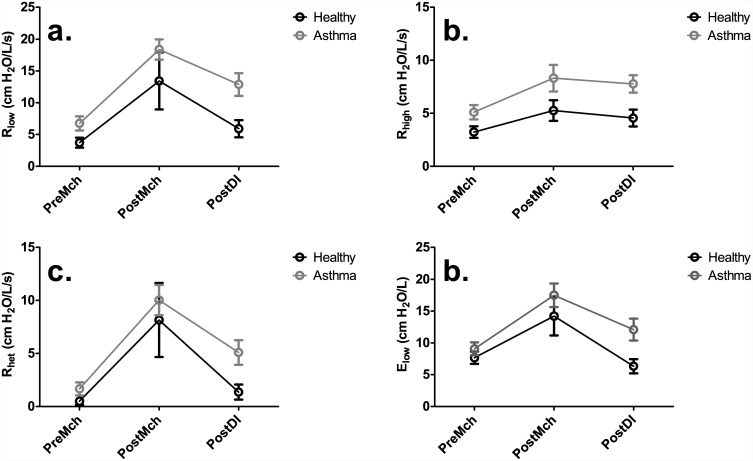
Dynamic lung mechanics measurements for PreMch, PostMch, and PostDI conditions, for Rlow (a.), Rhigh (b.), Rhet (c.), and Elow (d.) with corresponding standard errors.Again, across all three conditions, the mean values of all four indices of dynamic lung mechanics, Rlow, Rhigh, Rhet, and Elow for the asthmatic subjects were consistently higher than those for the healthy subjects, although not statistically significant. Refer to Tables 2 and 3 for statistical significance in comparisons between PreMch, PostMch, and PostDI.